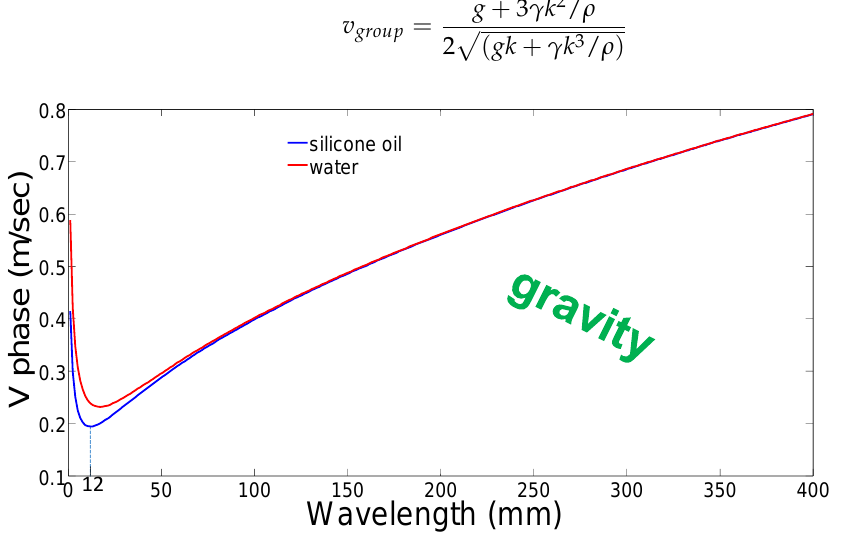
Figure 2. Speed as a function of wavelength for capillary waves at the liquid–air interface, for two different liquids: silicone oil (blue) and water (red).